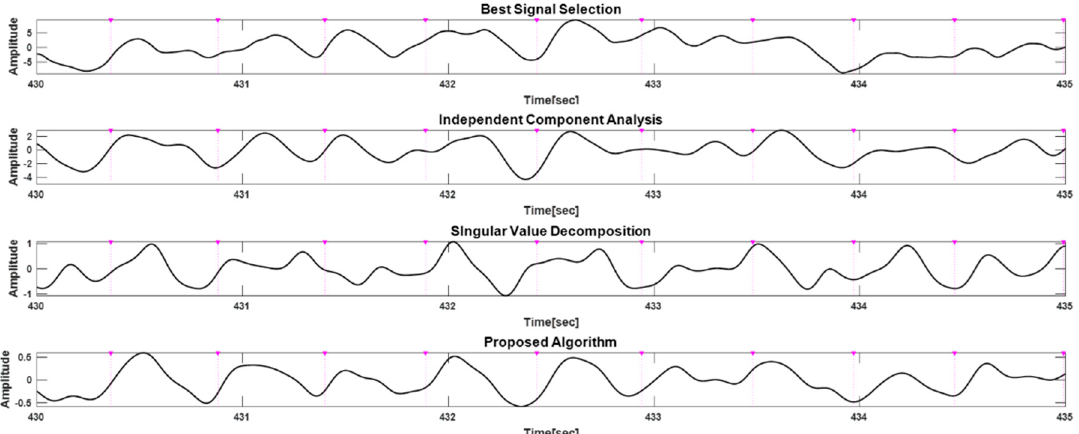
Figure 9. Example of applying the proposed method and algorithms based on best signal selection, ICA, and SVD during running at about 8 km/h.